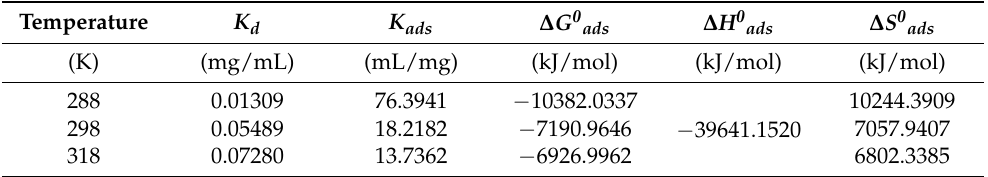
Table 5. The thermodynamic parameters for the adsorption of lysozyme onto the P-COOH-CS-RG19 nanofiber membrane at different